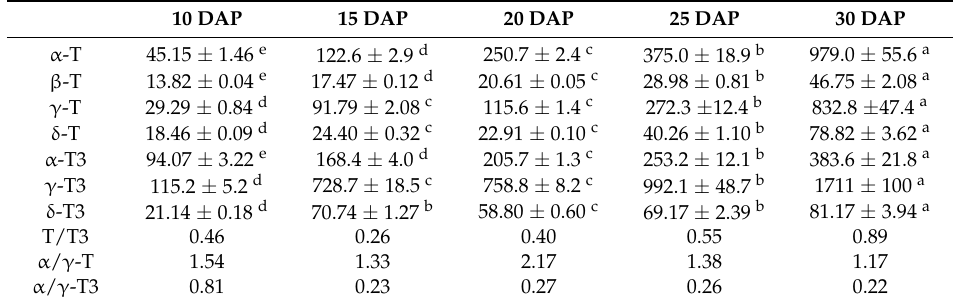
T = tocopherol; T3 = tocotrienol; α / γ = the ratio of total α -tocols/ γ -tocols. Different superscript letters in each line indicate statistically significant differences between the means ( p < 0.05) for each composition.